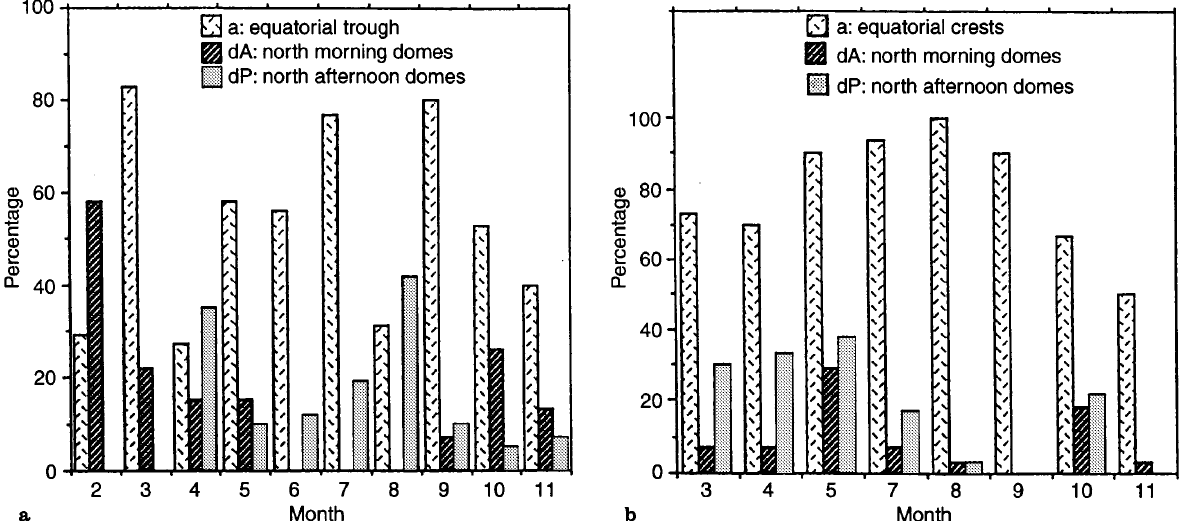
Fig. 9. a Monthly abundance percentages of dome and trough types 1993, b same percentages